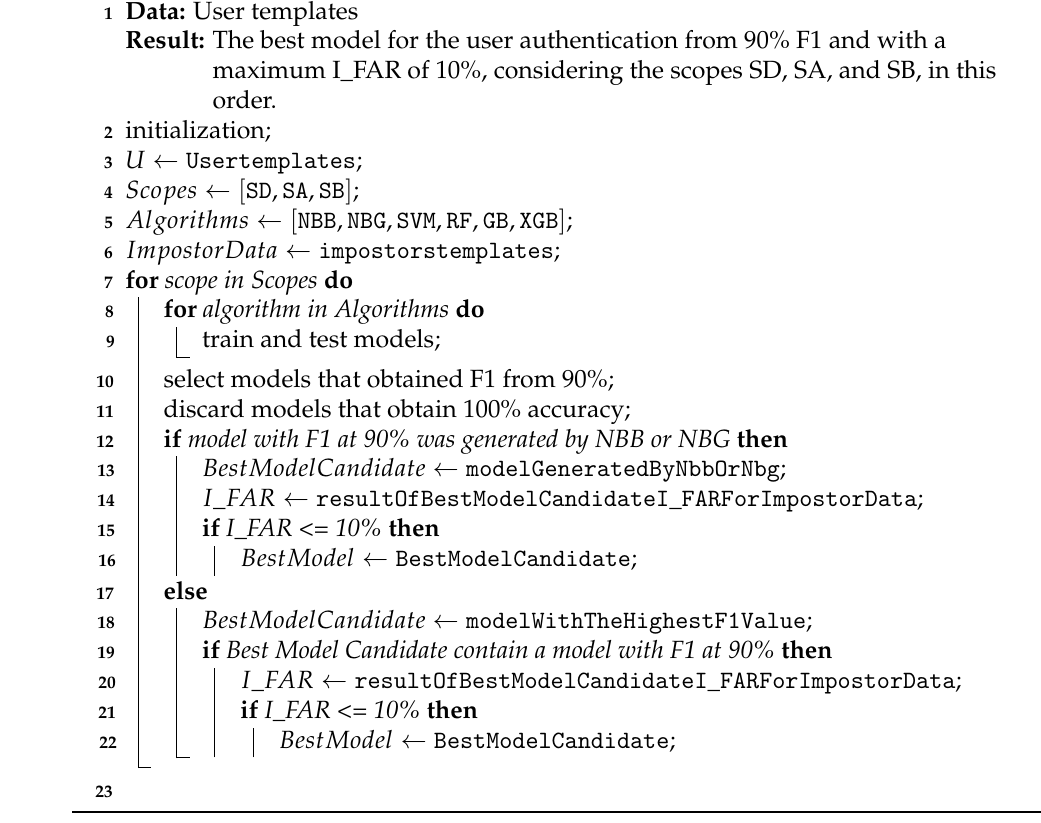
Algorithm 1: The flow of the framework algorithm with